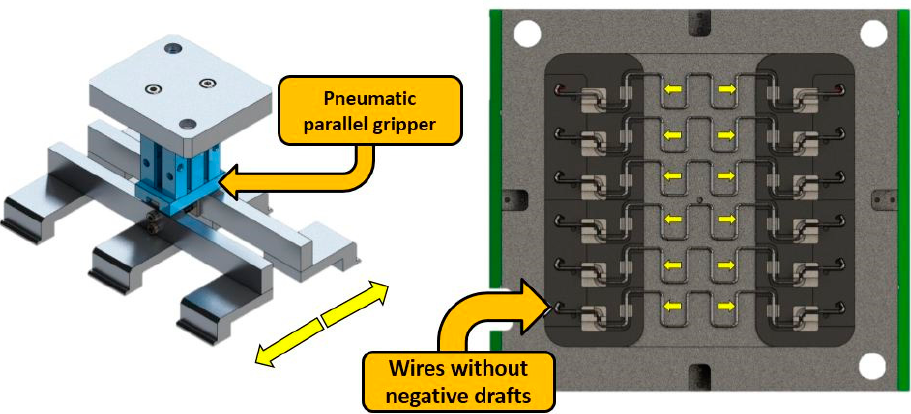
Figure 9. Extraction strategy of the injected components.